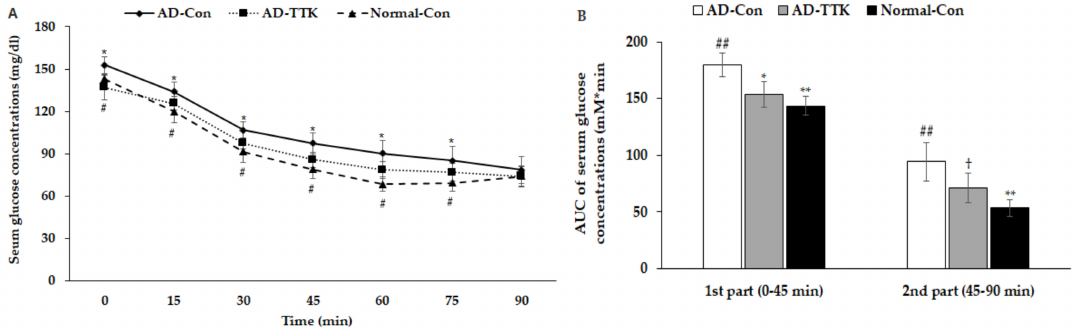
Figure 5. Systemic insulin resistance measured by intraperitoneal insulin tolerance test. After 6 h of food deprivation, serum glucose levels were measured at an assigned time after intraperitoneally insulin injection. ( A ) Changes of serum glucose concentrations. ( B ) The area under the curve (AUC) of glucose calculated in the first (0–30 min) and second phases (30–90 min). AD-Con fed 45% fat diet with 0.5% dextrin in AD rats infused intra-CA1 infusion of amyloid- β (25–35), AD-TTK fed 45% fat diet with 0.5% water extract of Tetragonia tetragonioides (TTK) in AD rats, and Normal-Con fed 45% fat diet with 0.5% dextrin in non-AD rats infused intra-CA1 infusion of amyloid- β (35–25). Each dot and bar represent Mean ± SD ( n = 10). # Significantly di ff erent among the groups in one-way ANOVA at p < 0.05 and ## p < 0.01. * Significantly di ff erent from AD-Con at p < 0.05 and ** p < 0.01 in the Tukey test. † Significantly di ff erent from the Normal-Con at p < 0.05 in the Tukey